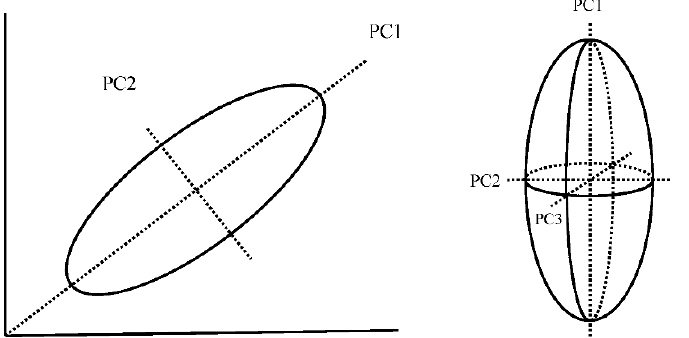
Figure 1. Transects of an ellipse ( left ) and an ellipsoid ( right ) to graphically show the three principal components (PCs 1–3) after principal component transformation (PC 4 is not presented as Jia et al. [1] did not use it).